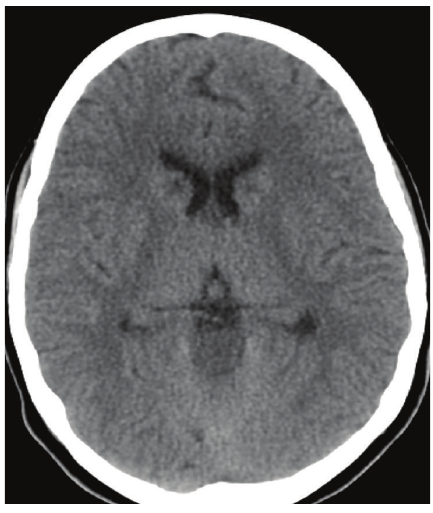
Figure 1: Axial images of Computed Tomography (CT) of brain showing bilateral hypodensities of the caudate